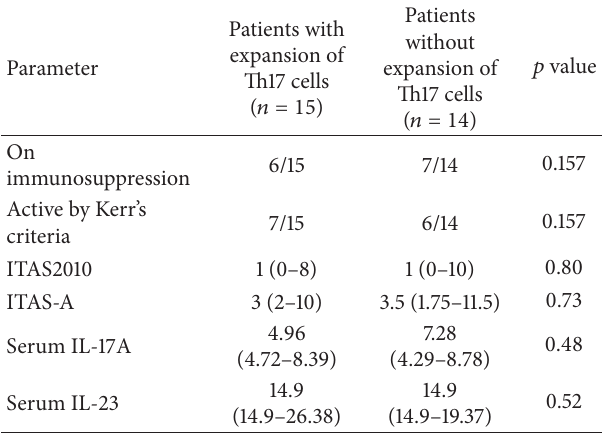
Table 3: Comparison of Th17 expanders versus the